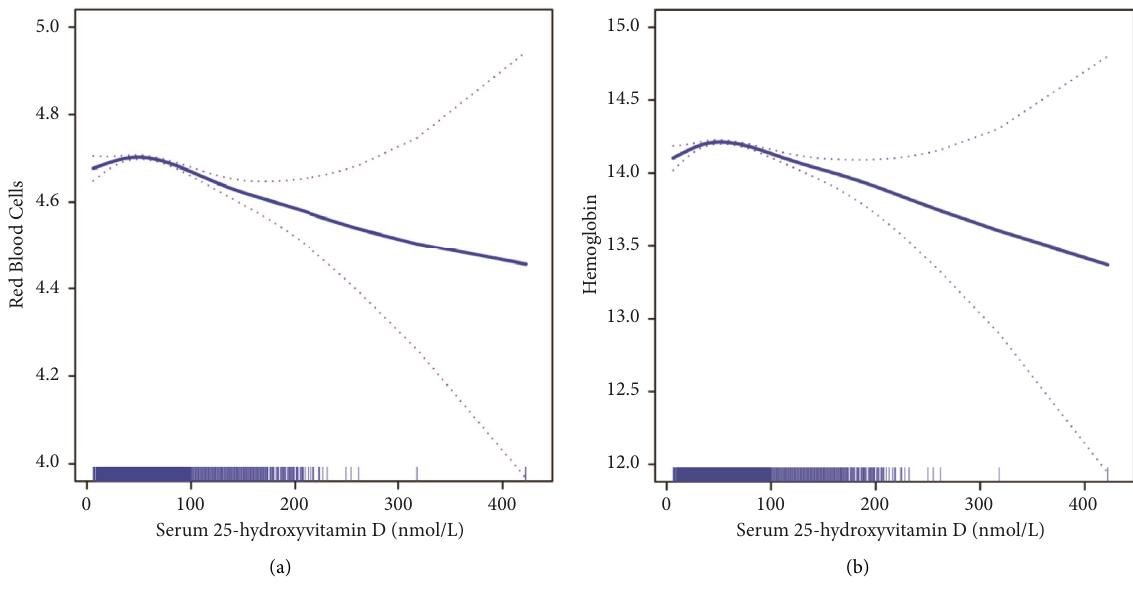
Figure 2: Associations of serum 25(OH)D with hemoglobin levels and red blood cell counts. (a) Association between serum 25(OH)D and hemoglobin level. (b) Association between serum 25(OH)D and red blood cell count.